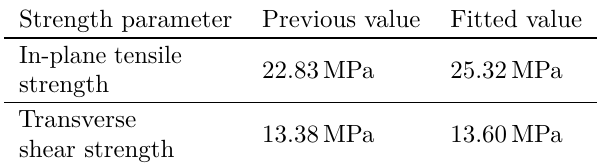
Table 4. Previous and fitted strength parameters.